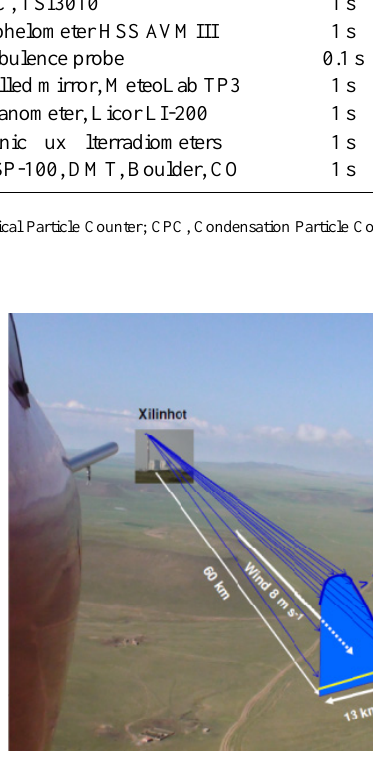
Fig. 3: Sketch of the ultrafine particle plume over the Inner Mongolian steppe downwind of Fig. 3. Sketch of the ultrafine particle plume over the Inner Mon- golian steppe downwind of Xilinhot (6 July 2009). Particle number Xilinhot (July 6, 2009). Particle number density outside plume area < 1200 cm -3 . density outside plume area < 1200cm − 3 . Horizontal flight track Horizontal flight track 50 m above ground 40 km. Blue: ultrafine particles, yellow: fine 50m above ground 40 km. Blue: ultrafine particles, yellow: fine particles D> particles D > 300 nm.